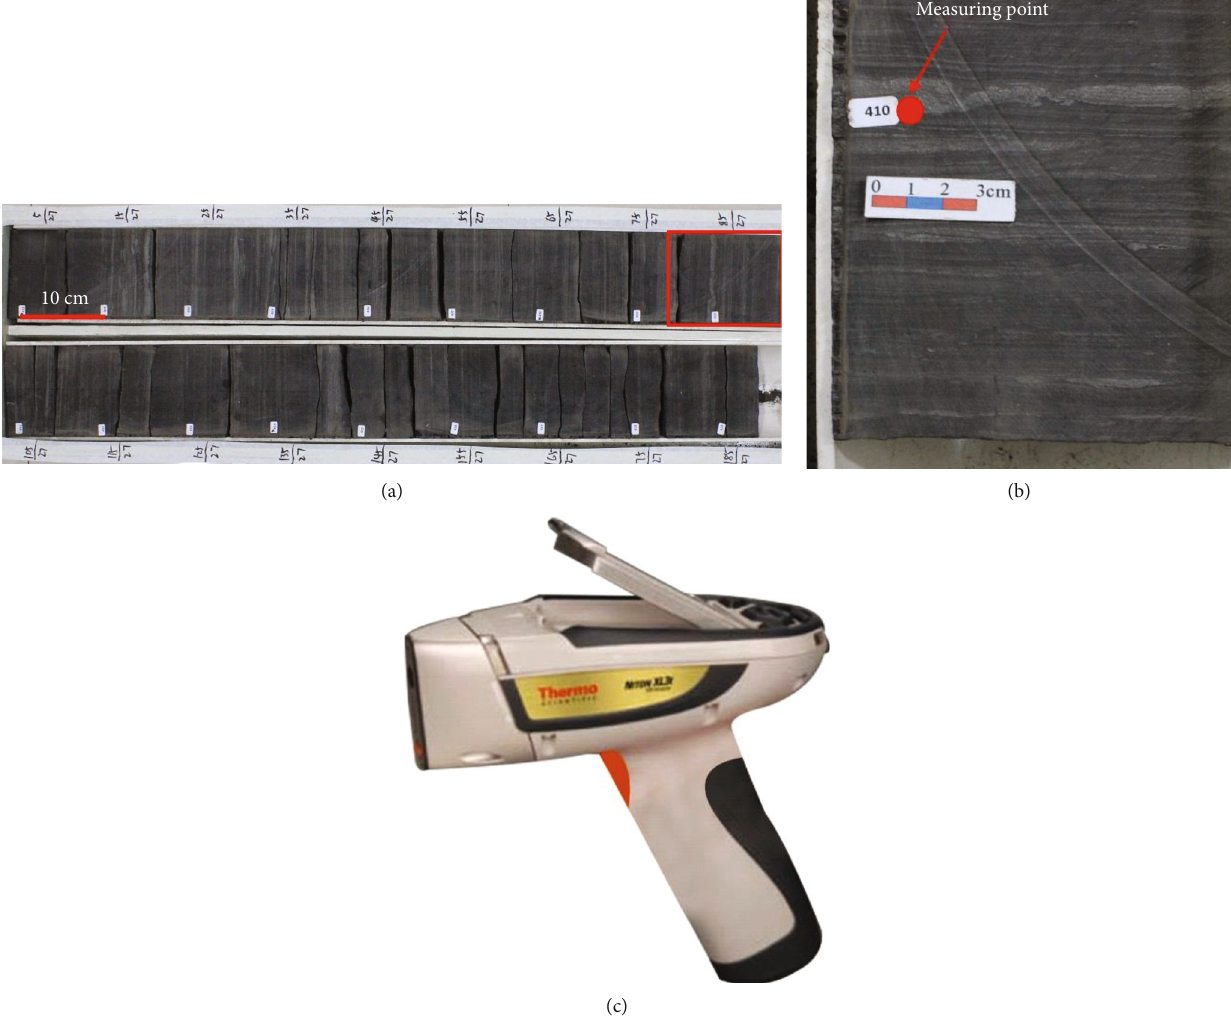
Figure 3: Major element test